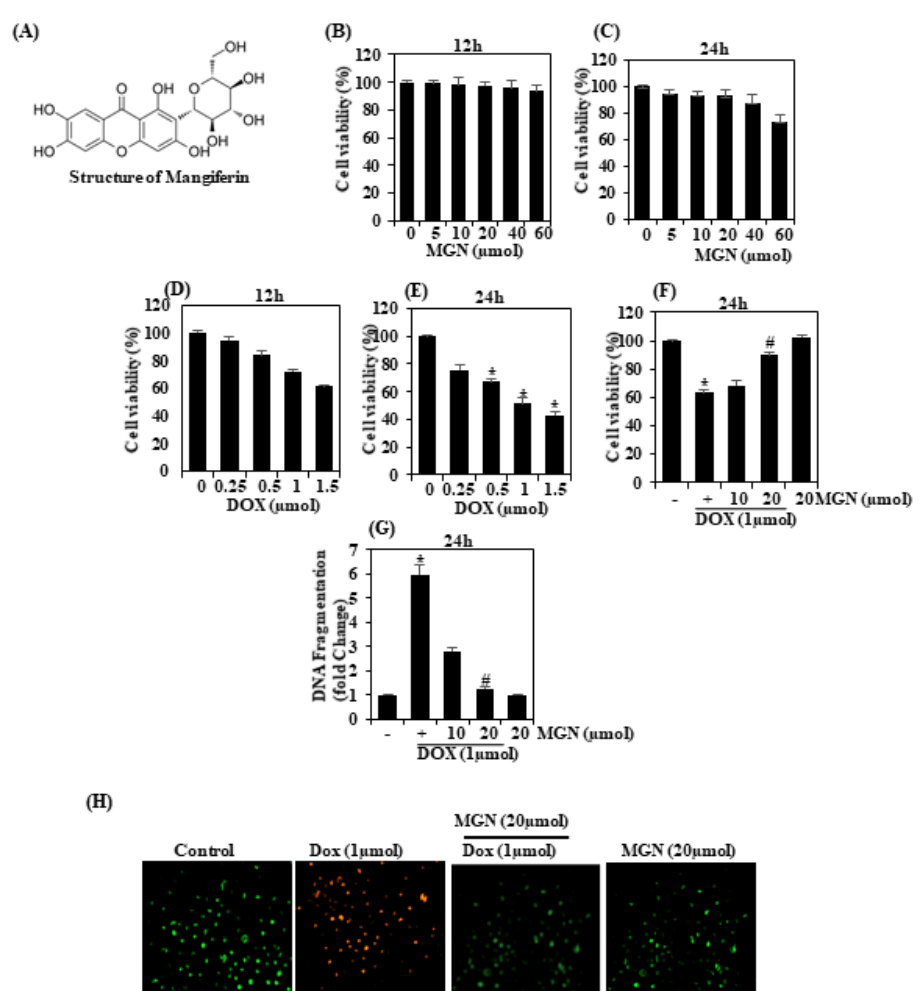
Figure 1. The effects of doxorubicin (1 µ M), mangiferin (MGN, 10 or 20 µ M) or a combination thereof on the proliferation of HUVECs. ( A ) Chemical structure of mangiferin. ( B , C ) MGN on HUVECs’ viability (0-60 µ M for 12 or 24 h, respectively). ( D , E ) Cell viability effect of DOX on HUVECs (0-1.5 µ M for 12 or 24 h, respectively). ( F ) MGN (10 or 20 µ M) cytoprotective on DOX (1 µ M)-induced HUVECs for 24 h. ( G ) Effect of MGN on DNA fragmentation in DOX-induced endothelial cells. ( H ) Acridine orange/ethidium bromide (AO/EB) staining observed for cell apoptosis for 24 h. The outcome was measured and expressed as a fold change compared to the control ( n = 3). Data were analyzed by one-way ANOVA, and Tukey’s post hoc experiments were used to analyze the similarities between groups. * p < 0.05 reflects significant differences from the healthy control. # p < 0.05 reflects significant differences in contrast to DOX alone and MGN with DOX-treated groups.